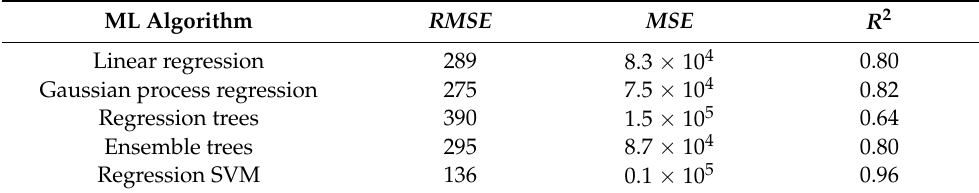
Table 2. Evaluation metrics of the trained ML models for dataset H5.